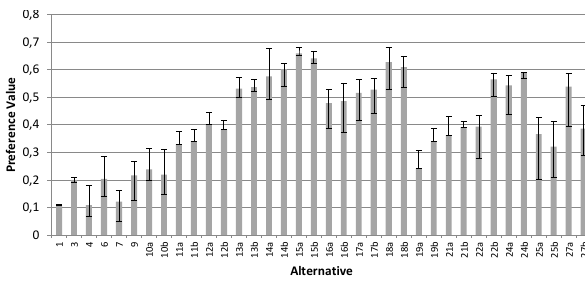
Figure 10. Preference values of stakeholder group “Municipalities” (bars) and fluctuation range due to different valuations of attributes within the stakeholder group